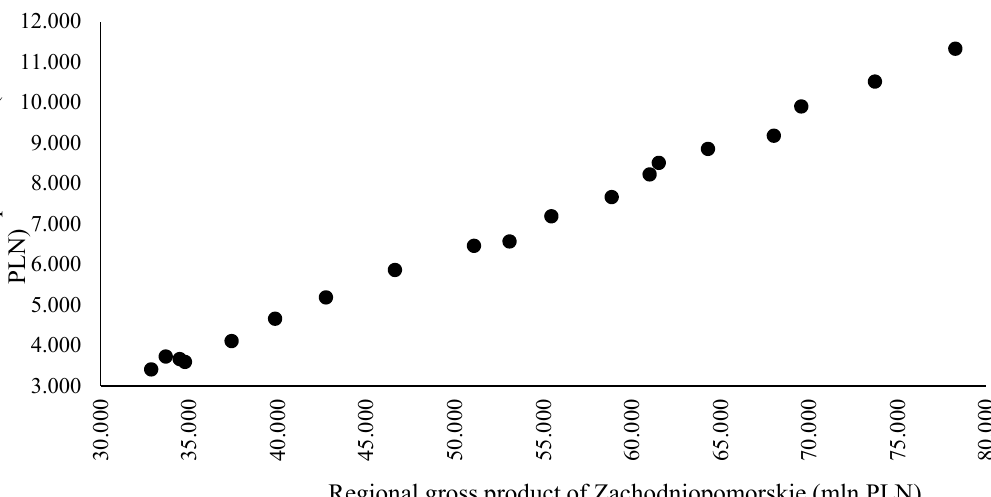
Figure 3. Relationship between revenue and gross product of Zachodniopomorskie voivodship in 2000–2018. Table 4. Results of estimation of the model for revenue (dependent variable) and regional gross product (independent variable) of Zachodniopomorskie (model 9).